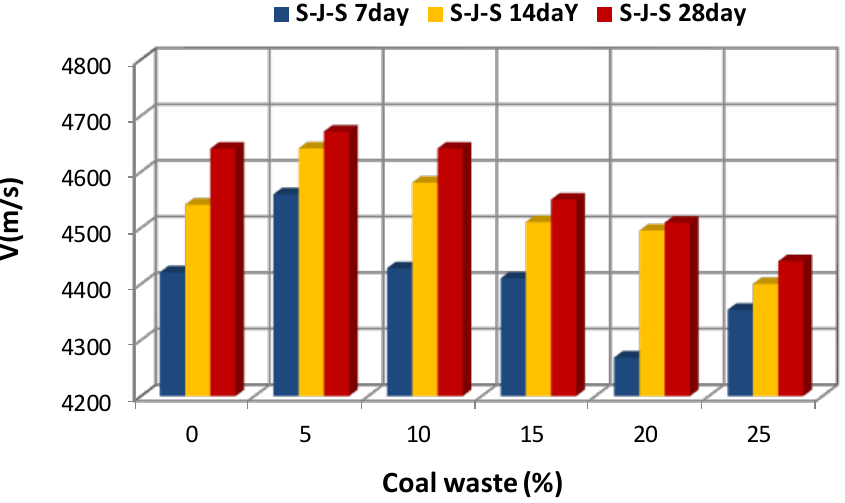
Figure 12. The effect of concrete age on the UPV of the S-J-S group .